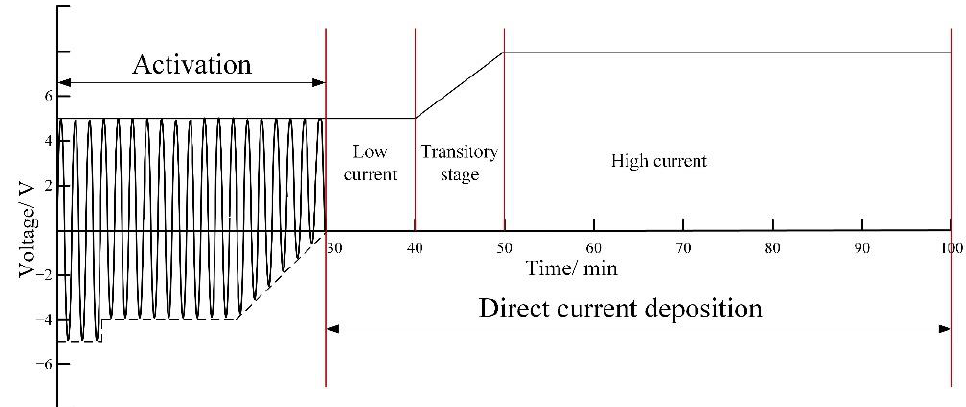
Figure 2. Diagram of electrical control parameter.